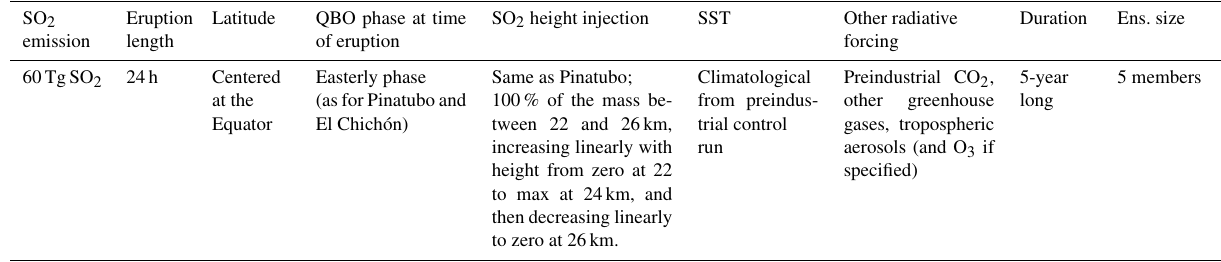
Table 5. Protocol for the chemistry–climate model experiment to assess volcanic forcing uncertainty for the volc-long-eq experiment. SO 2 Eruption emission